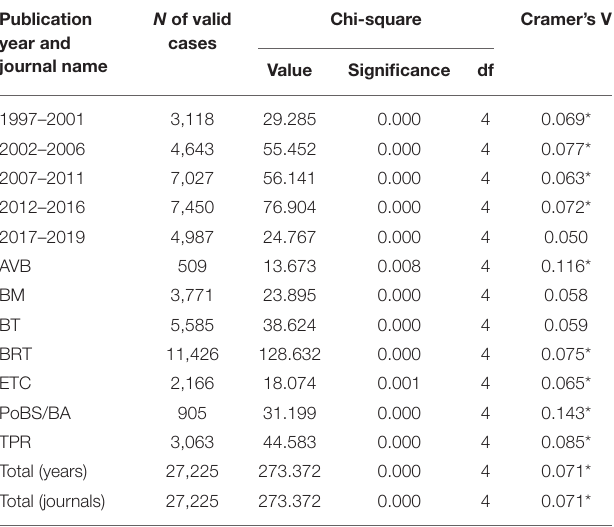
TABLE 4 | Chi-square and Cramer’s V statistics comparing author gender and authorship position by year group and